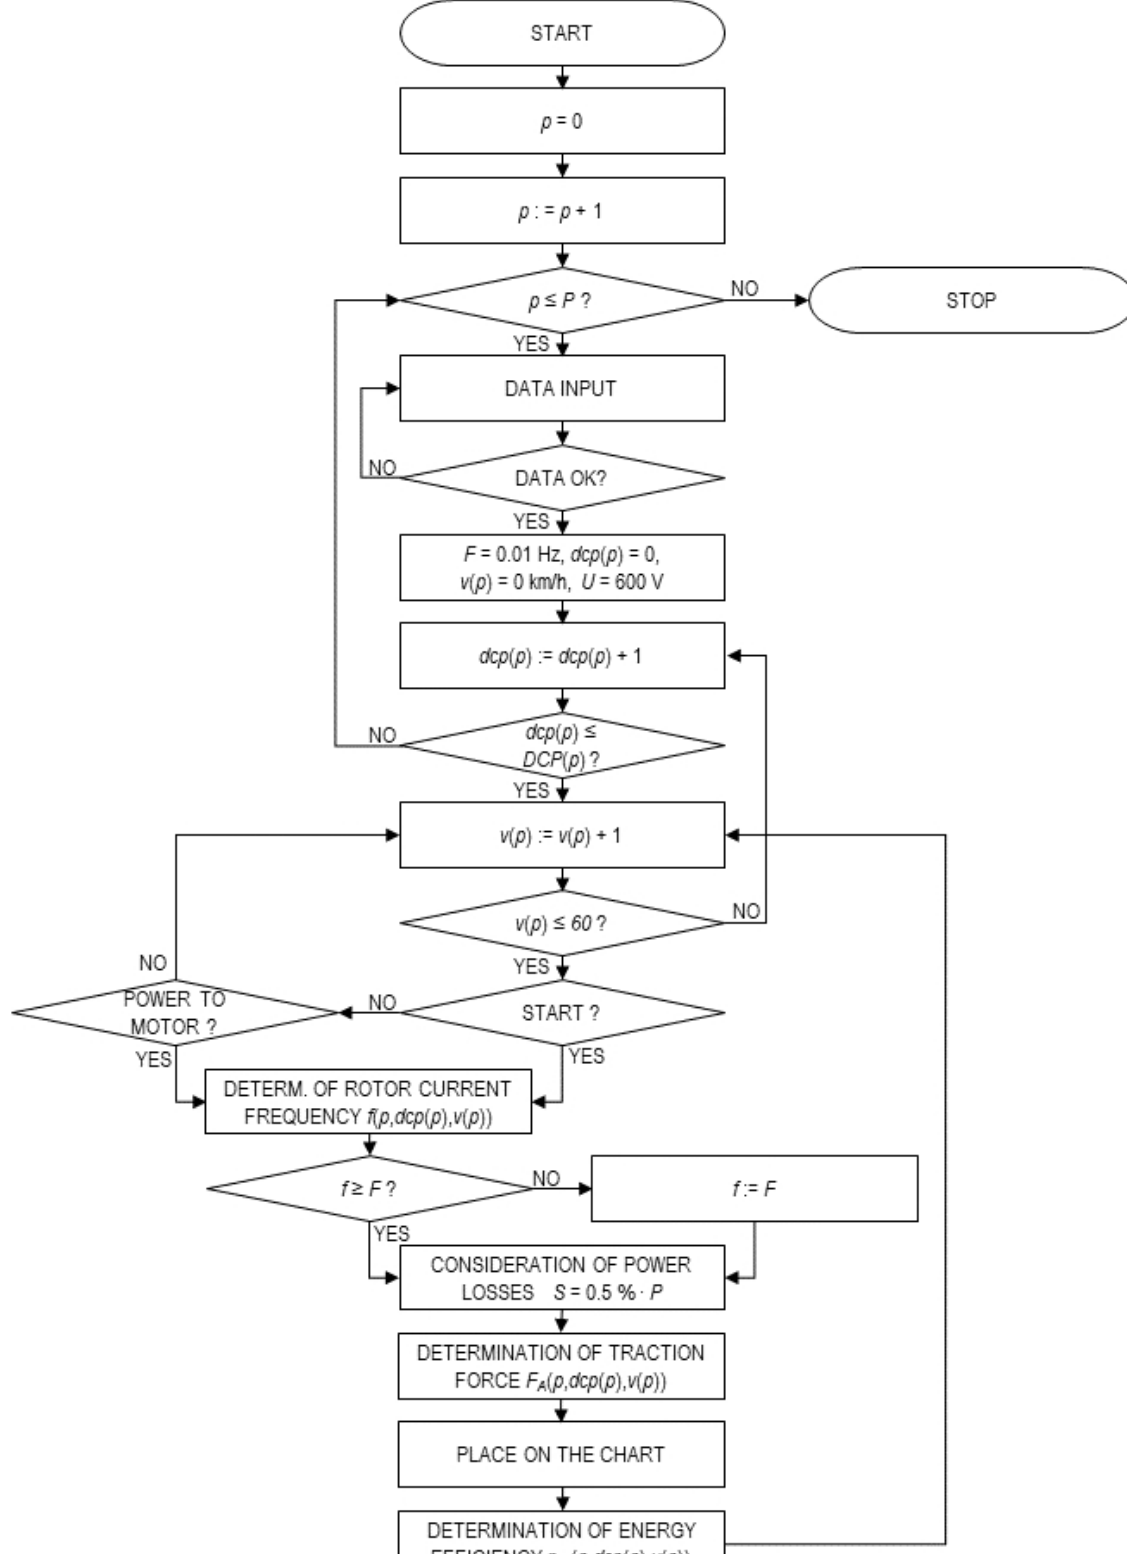
Figure 4. Author’s method of developing the traction characteristics of a vehicle equipped with an electric asynchronous traction motor and determining the engine’s energy efficiency. Source: own